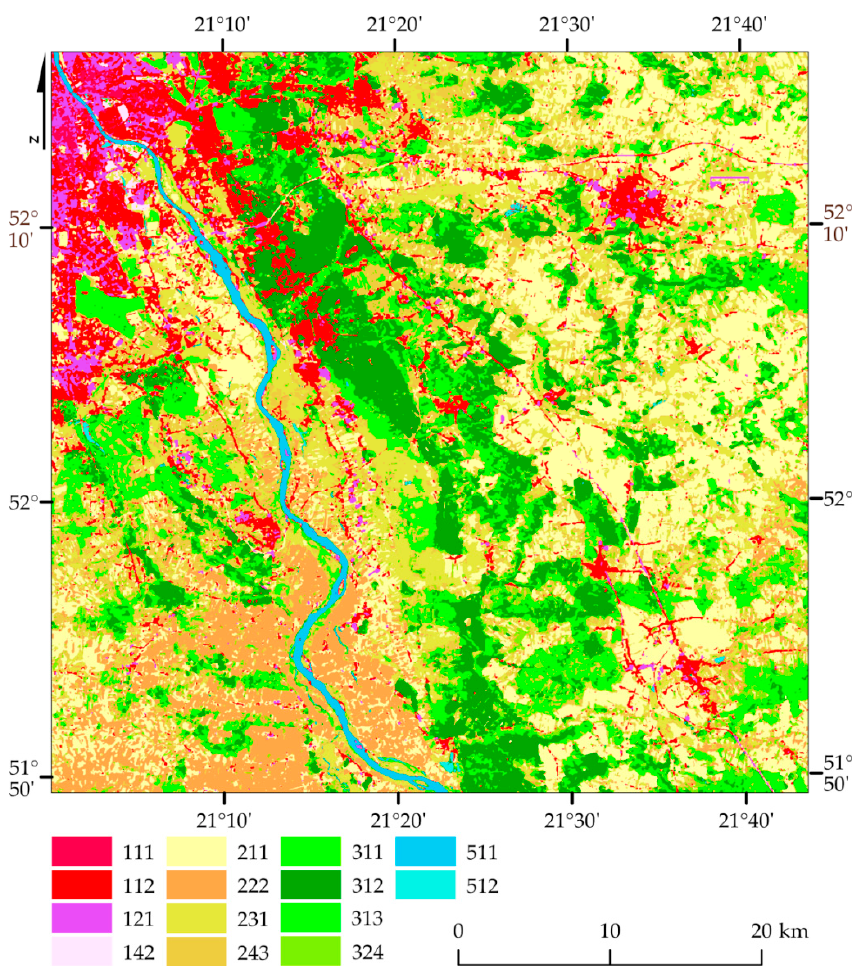
Figure 18. East Warsaw map based on Random Forest classifier, Sentinel-2 images, Overall accuracy: 80%, Kappa coefficient 0.78. Table 9. Confusion matrix of the East Warsaw area (RF, Sentinel-2 images, OA: 80%, Kappa coefficient 0.78, UA—User Accuracy, PA—Producer Accuracy, F1-score).